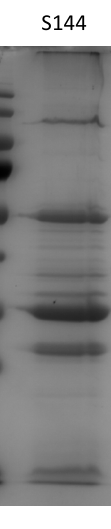
Figure A5. SDS-PAGE of the purified structural proteins of phage S144. A 12% SDS-PAGE separation gel of phage proteins (S144) were made alongside with a PageRuler TM Prestained Protein ladder (Thermo Scientific; M).